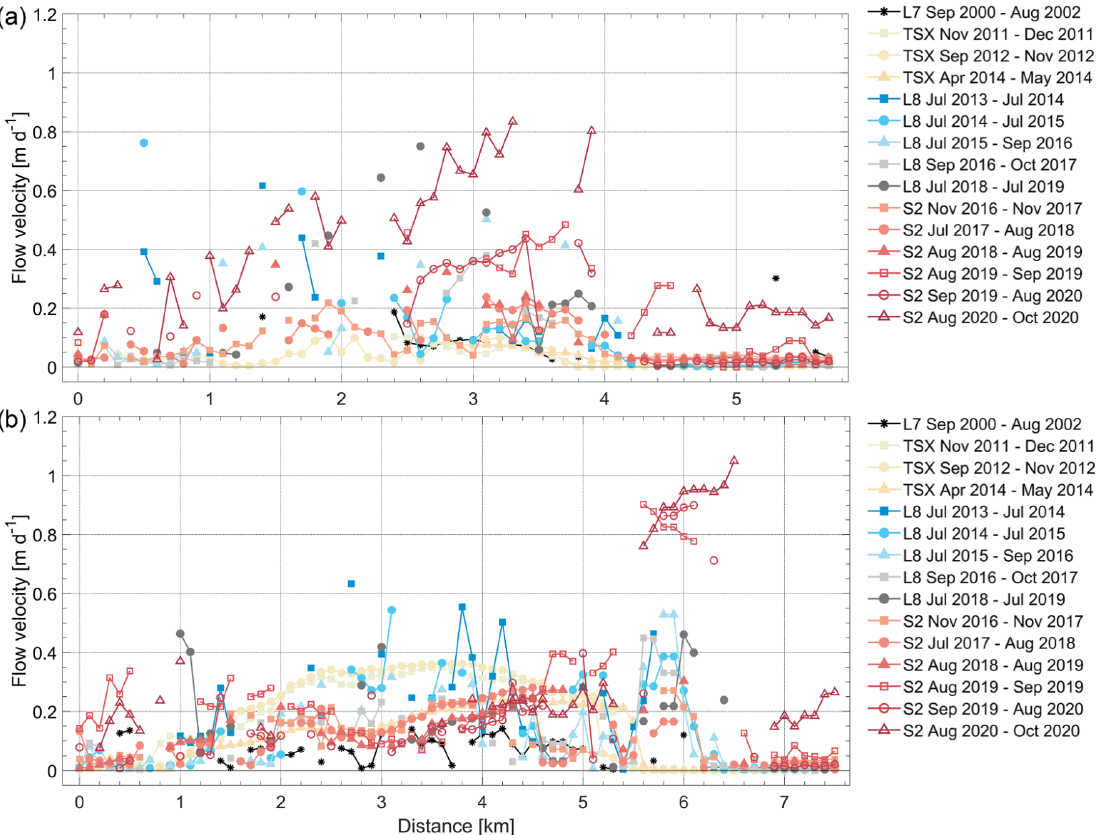
Figure 6. Temporal evolution of 1D flow velocities along a centreline starting at the highest point of each glacier for (a) glacier NN9 and (b) North Chongtar. Satellite names: L7 and L8 – Landsat 7 and Landsat 8, TSX – Terra-SAR-X, S2 –